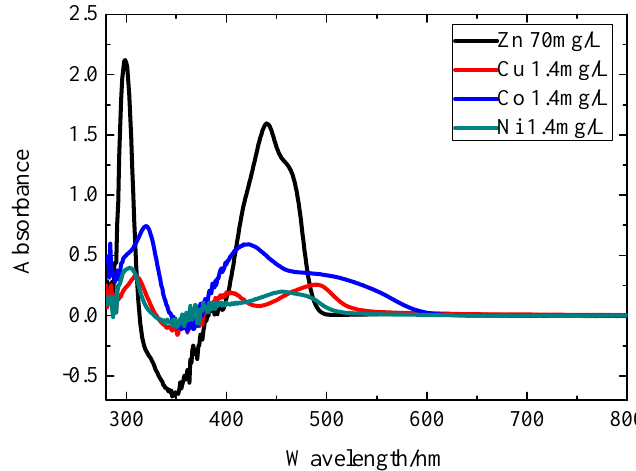
Figure 2. The single ion absorption spectrum for zinc, copper, cobalt, and nickel,